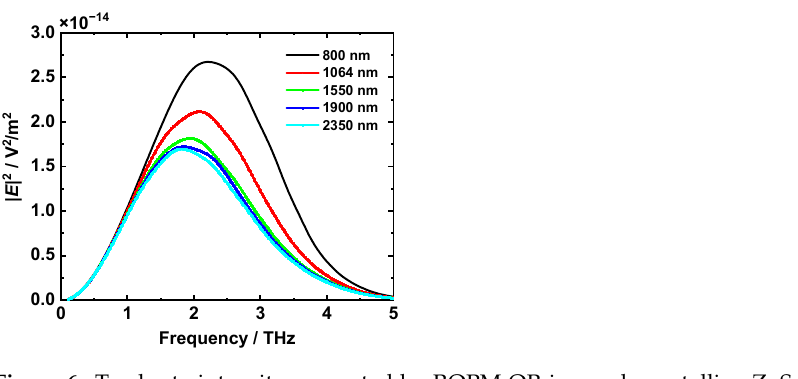
Figure 6. Terahertz intensity generated by RQPM OR in a polycrystalline ZnSe sample pumped at different wavelengths. The grain size distribution ( μ , σ ) was (82, 35) in micron, the pump pulse duration was 100 fs and the pump intensity was 30 GW/cm 2 .